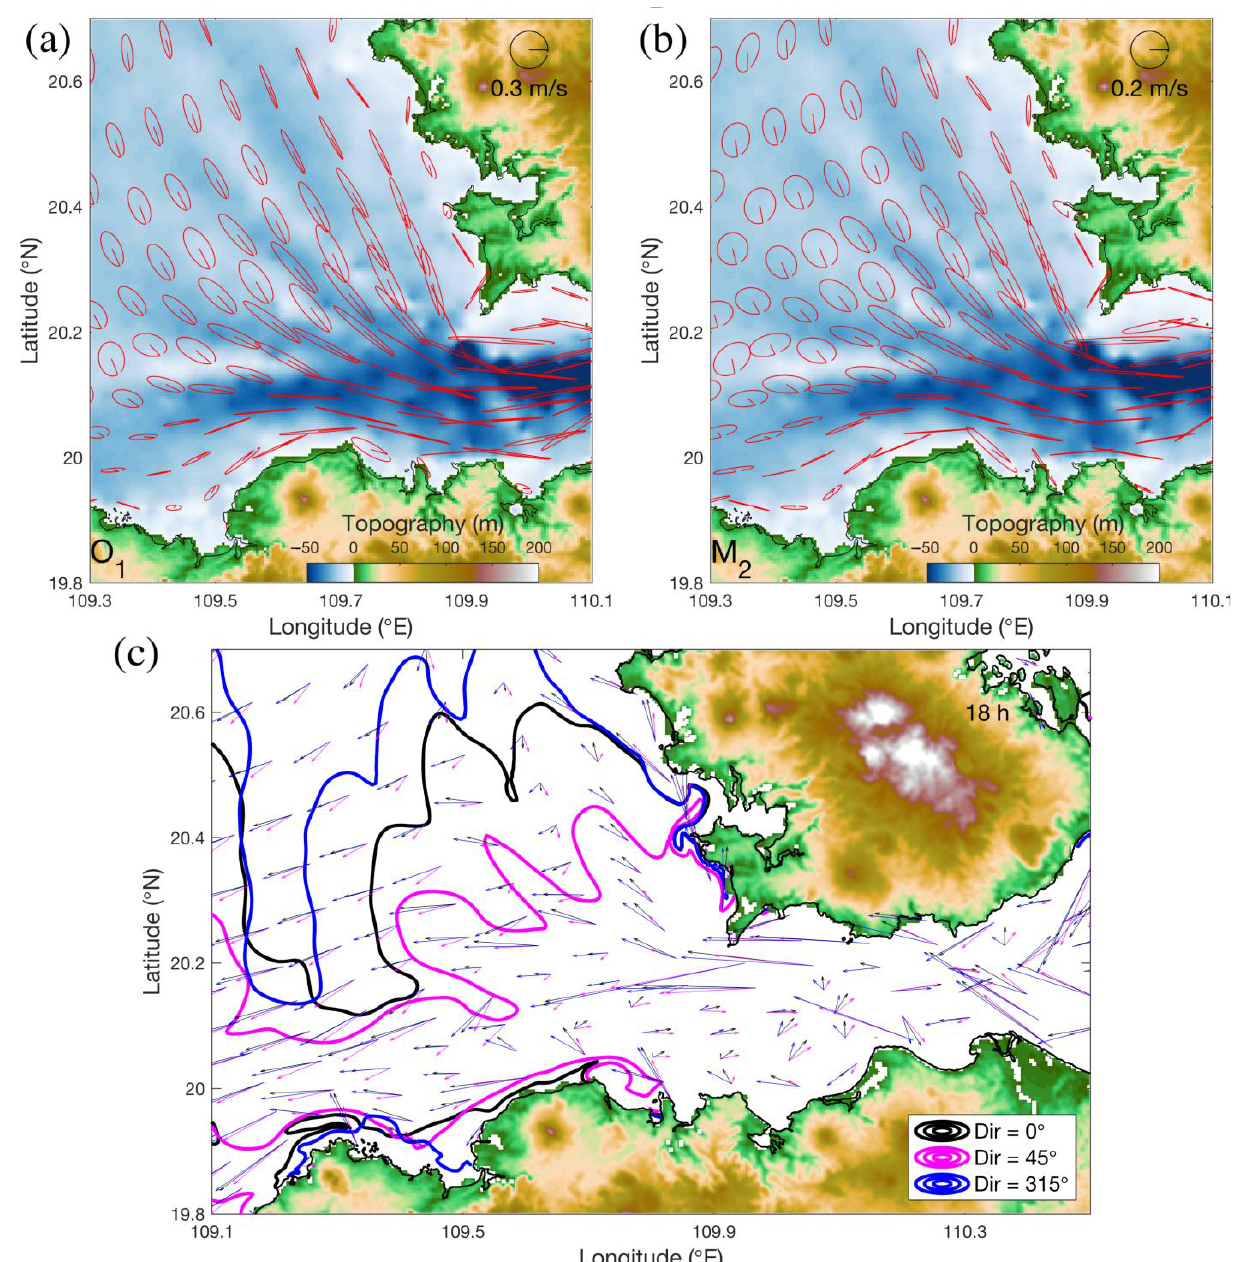
Figure 14. Distribution of diurnal ( a ) and semi-diurnal ( b ) surface tidal current ellipses in the studied region. The O 1 and M 2 tidal current constituents are selected as representatives of diurnal and semi-diurnal components, respectively. ( c ) Comparisons of SST distribution (31.45 °C isotherm) and surface current vectors modeled by EXP_D45 (in purple), EXP_D0 (in black), and EXP_D315 (in blue).